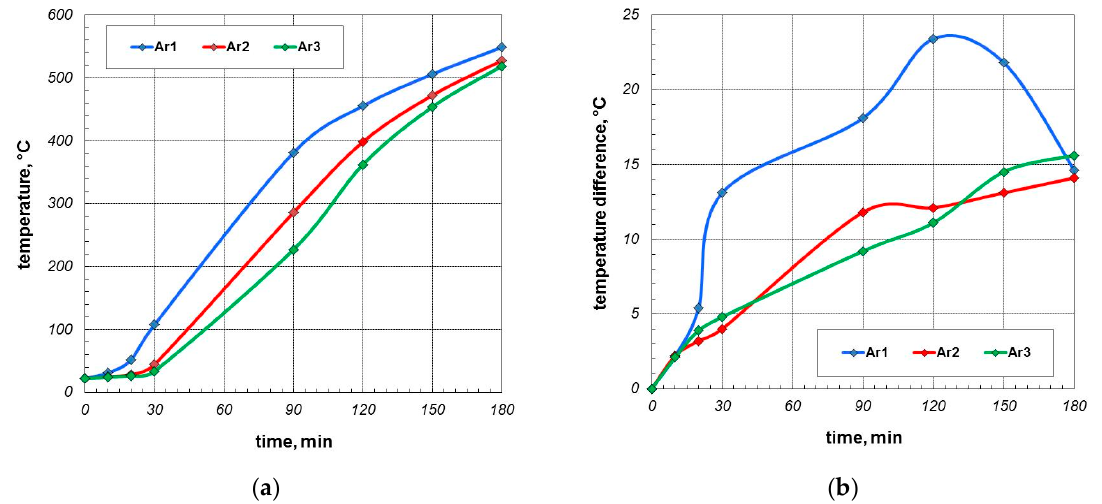
Figure 19. Changes of selected parameters determined for areas Ar1–Ar3: ( a ) changes in average temperature; ( b ) changes in the temperature difference Δ t.